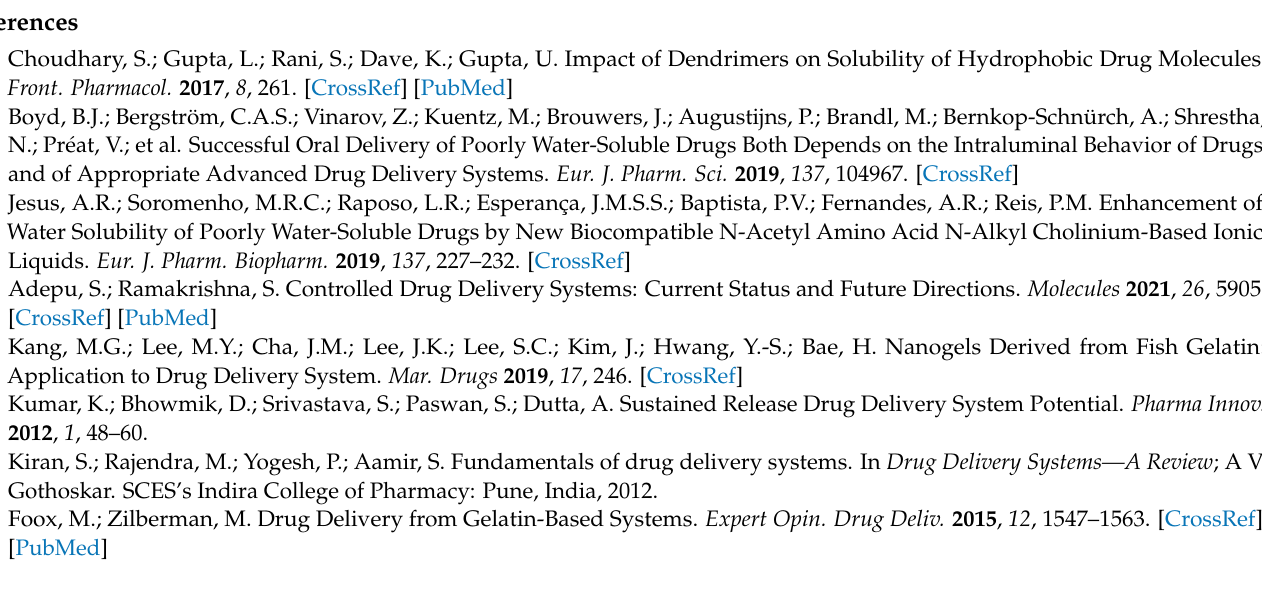
represent 95% confidence intervals; Figure S12: AFM images of shark gelatin hydrogel. (a) Zone 1 at a magnification of 10 × 10 µ m 2 , (b) Zone 2 at a magnification of 10 × 10 µ m 2 . (c) Image 2D with a field of view 1.6 × 1.6 µ m 2 , (d) Image 2D with a field of view 849.5 × 849.5 µ m 2 , (e) Image 2D in Zone 1 at a magnification of 5 × 5 µ m 2 , (f) Zone 2 at a magnification of 5 × 5 µ m 2 ; (g), (h) Zone 1, Image 3D; Figure S13: Zoom images 3D with magnifications 120 × 120 nm 2 of shark gelatin hydrogel. (a) Zone 1; (b) Zone 2; Figure S14: (a) Cryo-SEM images; (b) Image of Zone 1 at a magnification of 0.84 × 0.84 µ m 2 ; (c) Image of Zone 2 at a magnification of 1.1X1.1 µ m 2 of hydrogel gelatin; Figure S15: (a) Zone 2 of GE/25IL; (b) Zone 2 of GE/5IL Topographic 2D images Zone 2, 10 × 10 µ m 2 ; (c) Zone 1, Image 2D Field of View 1.5 × 1.5 µ m 2 of GE/25IL; (d) Zone 1, Image 3D Field of View 1.5 × 1.5 µ m 2 of GE/25IL; (e) Zone 1, Image 2D, Field of View 1.5 × 1.5 µ m 2 of GE/5IL; (f) Zone 1, Image 3D Field of View 1.5 × 1.5 µ m 2 of GE/25IL; (g) GE/5IL of Zone 1; (h) GE/5IL of Zone 2; Figure S16: Imaging of WLOP method. (a) 2D image at 5x_2x (443.2 × 582.5 µ m 2 ; (b) 20x_2x (110 × 144 µ m 2 ; (c) 250x_2x (44 × 58 µ m 2 ); (d) 3D magnification 5X_FOV 2X (443.2 × 582.5 µ m 2 ; (e) 3D magnification 20X_2X (110 × 144 µ m 2 ), (f) 3D magnification 50X_2X (44 × 58 µ m 2 ); Table S8: Roughness parameter values obtained by WLOP of shark gelatin hydrogel; Figure S17: Complex viscosity variation (filled storage modulus (G (cid:48) , filled ∆ ) and loss modulus (G”, open ∆ ) versus temperature of gelatin hydrogel (orange color) and Ionogel (fuchsia